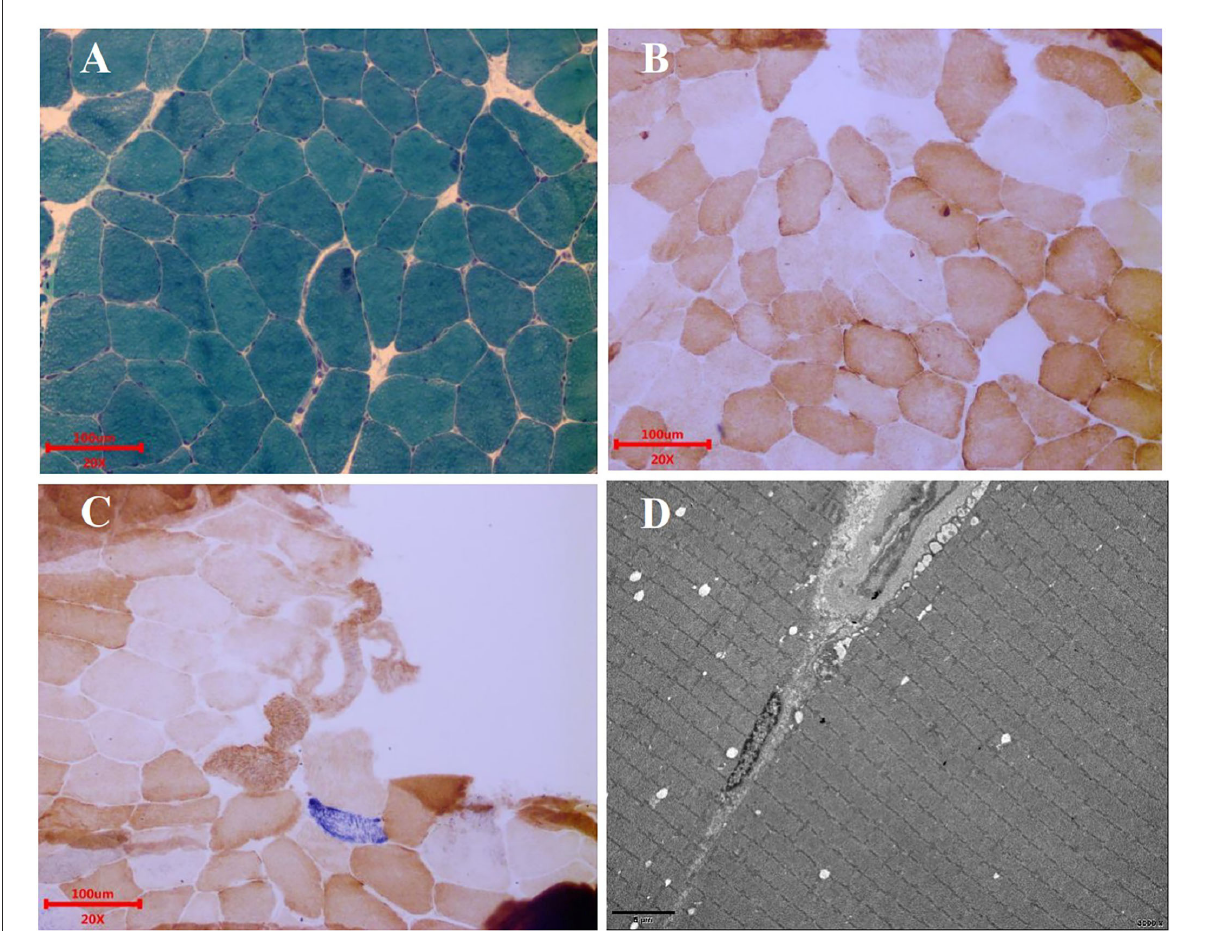
FIGURE3 Muscle biopsy. (A) MGT staining showed no ragged red fibers. Scale bars: 100 µ m. (B) COX staining showed no significant decrease in myofibrillase activity. Scale bars: 100 µ m. (C) SDH/COX double staining found one blue fiber. Scale bars: 100 µ m. (D) Under the electron microscope, the basic arrangement of myofibrils was regular, the sarcolemma was shrunken, and no special ultrastructural and pathological changes were found. Scale bars: 5 µ